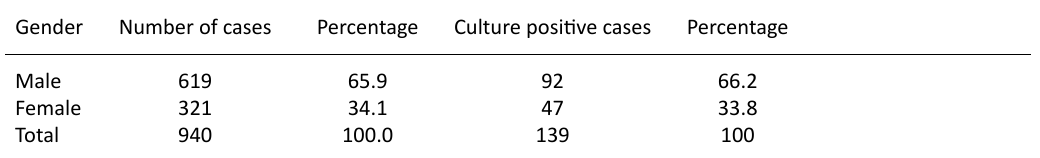
Table 2. Age wise distribution of the isolated organisms